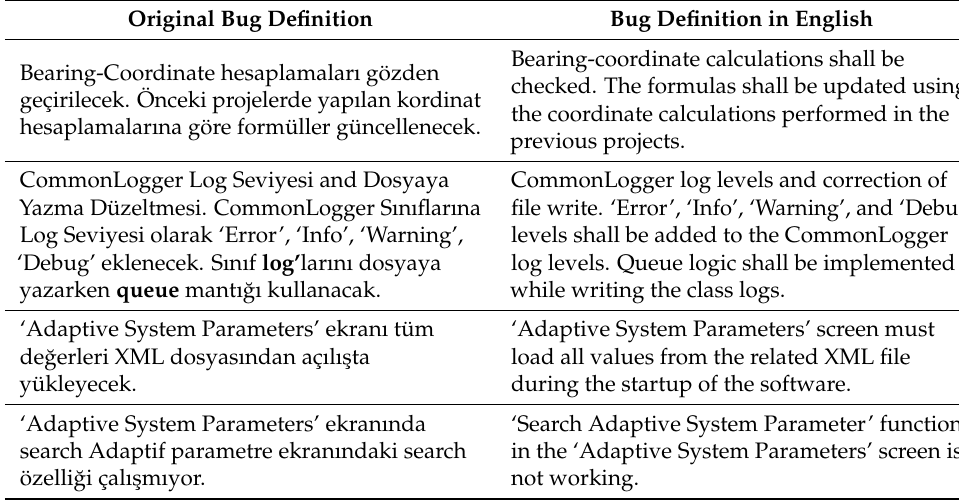
Table 2. A sample set of unstructured bilingual bug report